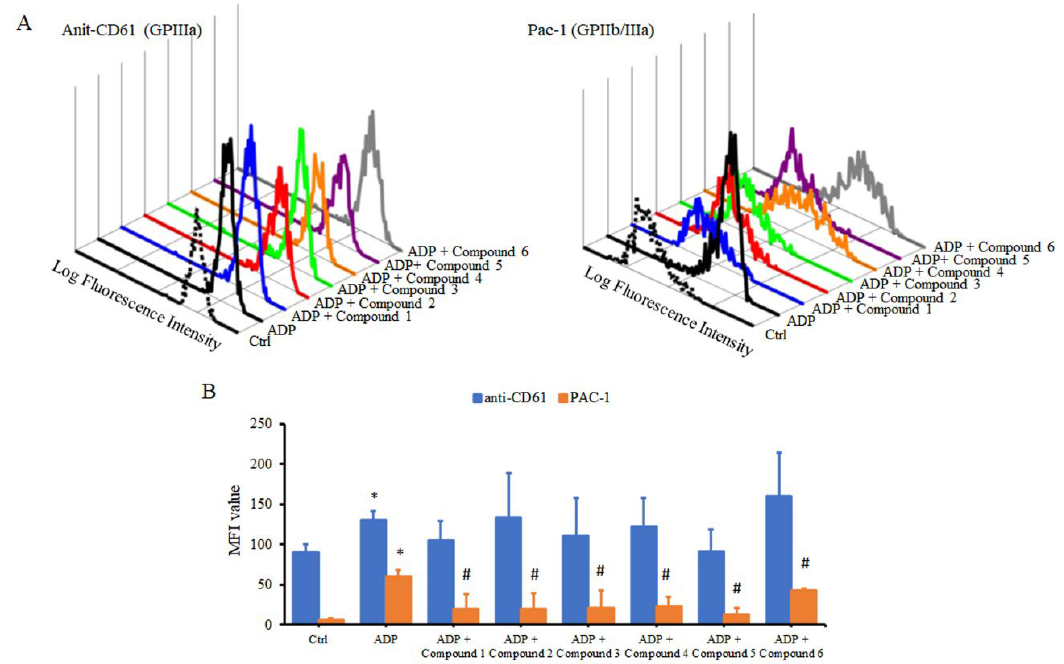
Figure 3. Effects of coumarin derivatives on the expression of glycoproteins on human platelet membranes. Human blood was treated with 10 ppm of coumarin derivatives for 30 min, followed by the addition of 20 μM ADP for 30 min. The expression of GPIIIa and active form of GPIIb/IIIa on the membrane was analyzed using flow cytometry. The flow data for GPIIIa and GPIIb/IIIa on platelet membranes from one of three independent experiments ( n = 3) ( A ). Experimental results are sum- marized as MFI values of platelet membrane ( B ). * p < 0.05 compared with the control group. # p < 0.05 compared with whole blood stimulated with ADP alone.